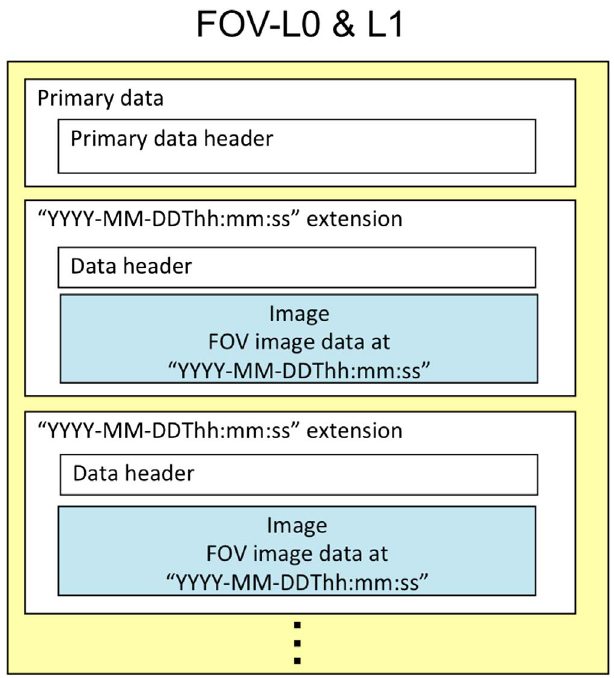
Fig. 4. FITS fi le structures of FOV-L0 and L1. In addition to the scienti fi c data extension “ YYYY-MM-DDThh:mm:ss ” (see text for detailed contents), the fi le stores a primary data